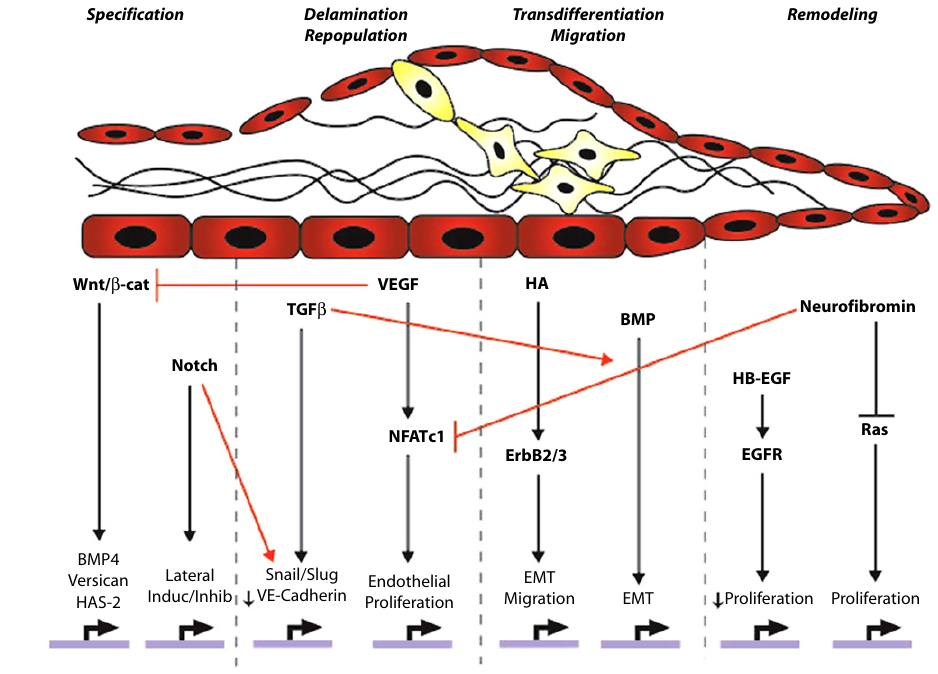
Figure. 3 Anatomic and signaling events during early valve development. Numerous pathways either synergistically (black arrows) or through inhibitory interactions (blunt red arrows) coordinate the early events of endocardial cushion formation and EMT (for detailed overview see Fig. 2). The repopulation, differentiation and migration of endothelial cells into the ECM/ cardiac jelly are the first signs of the developing valves. Picture taken from Armstrong and Bischoff Circ. Res. 2004; 95; 459–470